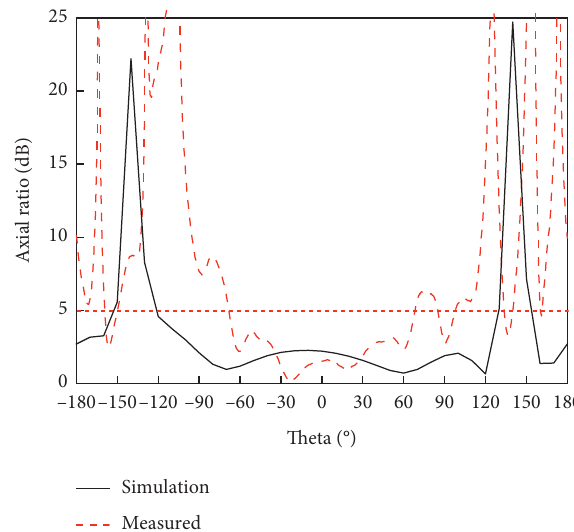
Figure 10: Measured and simulated results of axial ratio at ϕ � 0 ° for the reconfigurable antenna element (at 2.6GHz).